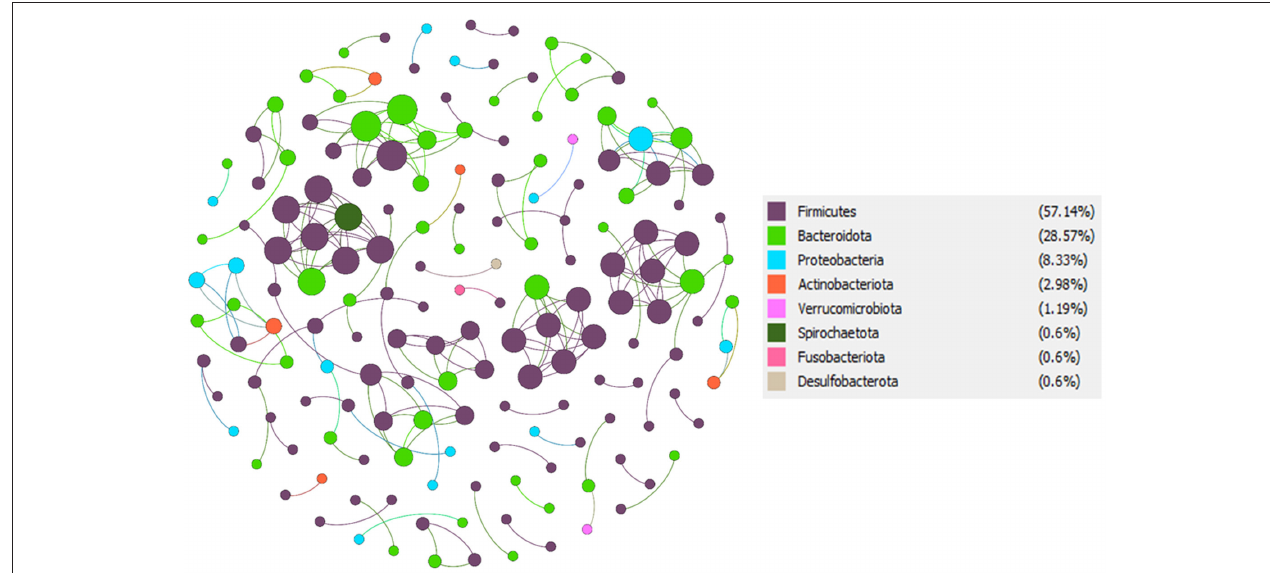
FIGURE 7 | T2D co-occurrence network (TCN). From total OTU abundance data, we select the T2D specific OTUs using the specified criteria, and a co-occurrence microbial network was constructed in